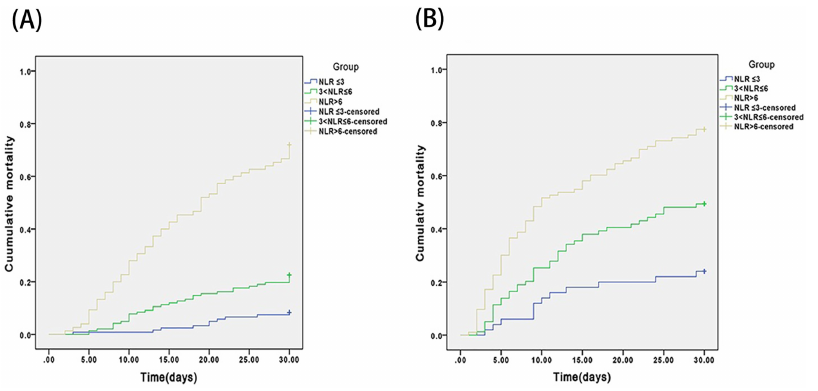
Fig 4. Cumulative 30-day mortality in ALSS (A) and SOC (B) patients with NLR (cid:20) 3, 3–6, and >